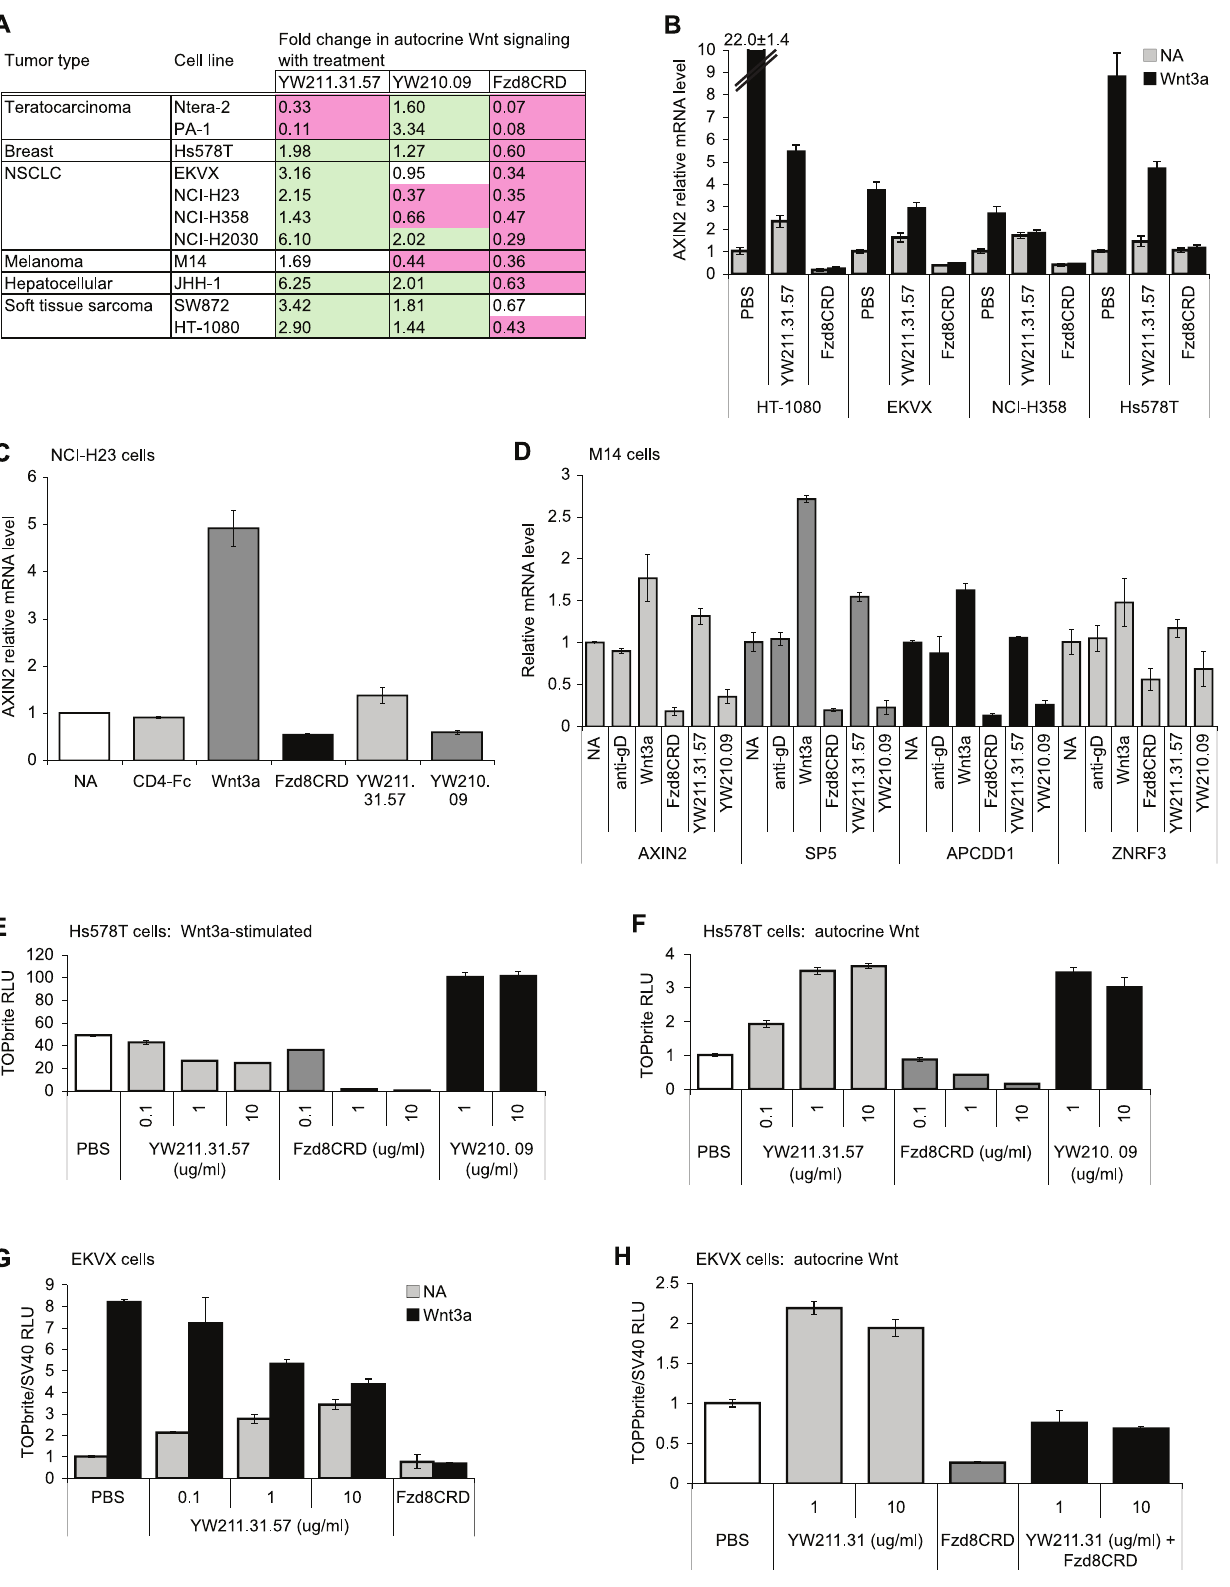
Figure 2. LRP6 antibodies can have different effects on autocrine Wnt signaling in other cell lines. (A) Summary table of 11 cell lines displaying autocrine Wnt signaling inhibited by Fzd8CRD-Fc protein (10 m g/ml), and the effects of LRP6 antibodies on autocrine signaling. The fold change in autocrine Wnt signaling is highlighted in red or green to indicate inhibition or potentiation, respectively, with p-value , 0.01 by one-way analysis of variance (ANOVA). Antibodies were used at 10 m g/ml, except for NCI-H358 and HT-1080 cells which were treated with 1 m g/ml